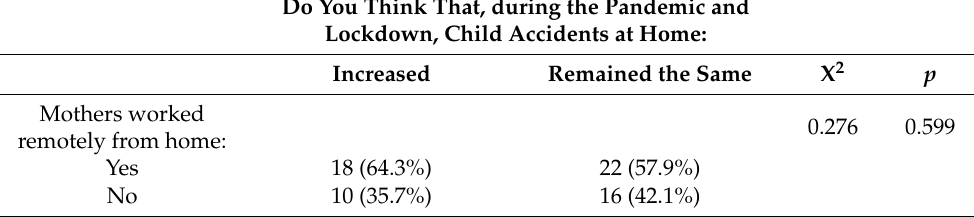
Table 6. Comparison of the increase in accidents in relation to the mother’s change in occupational